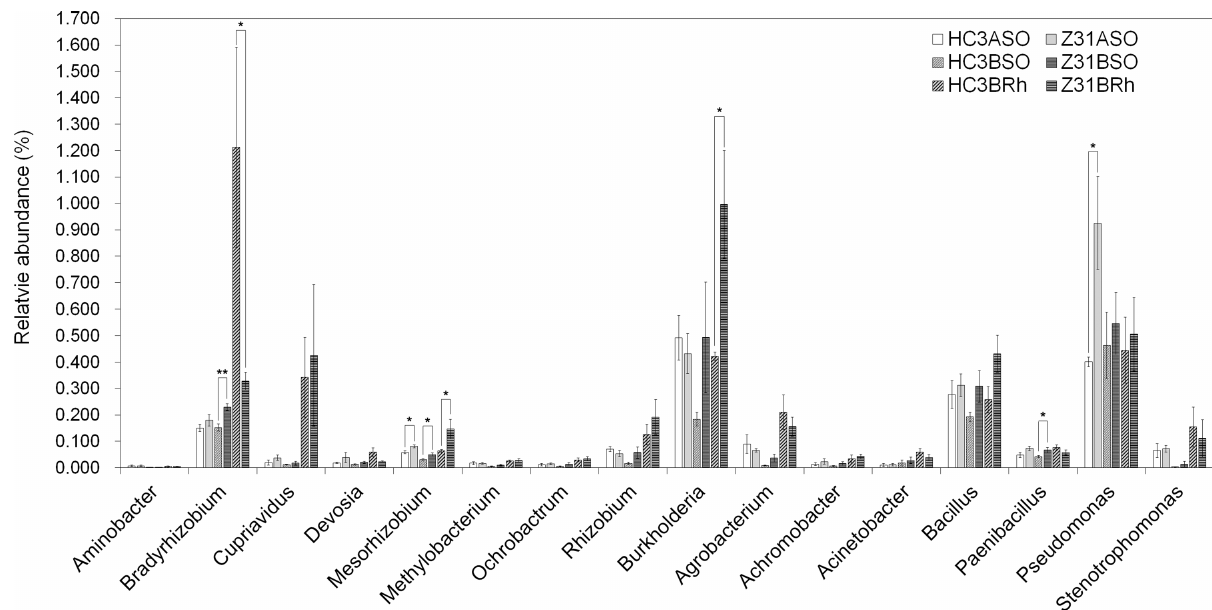
Fig 4. Relative abundances of main nitrogen-fixing bacterial genera at the vegetative stage. HC3BRh and Z31BRh represent the rhizospheric soils of the recipient cultivar HC3 and the transgenic line Z31 at the vegetative stage, respectively. HC3BSO and Z31BSO represent the surrounding soils of the recipient cultivar HC3 and the transgenic line Z31 at the vegetative stage, respectively. HC3ASO and Z31ASO represent the bulk soils before sowing seeds of the recipient cultivar HC3 and the transgenic line Z31, respectively. Error bars indicate the standard errors (SE) calculated by Metastats. Values are mean ± SE (n = 4 or 6); (cid:3) , P < 0.05; (cid:3)(cid:3) , P < 0.01.